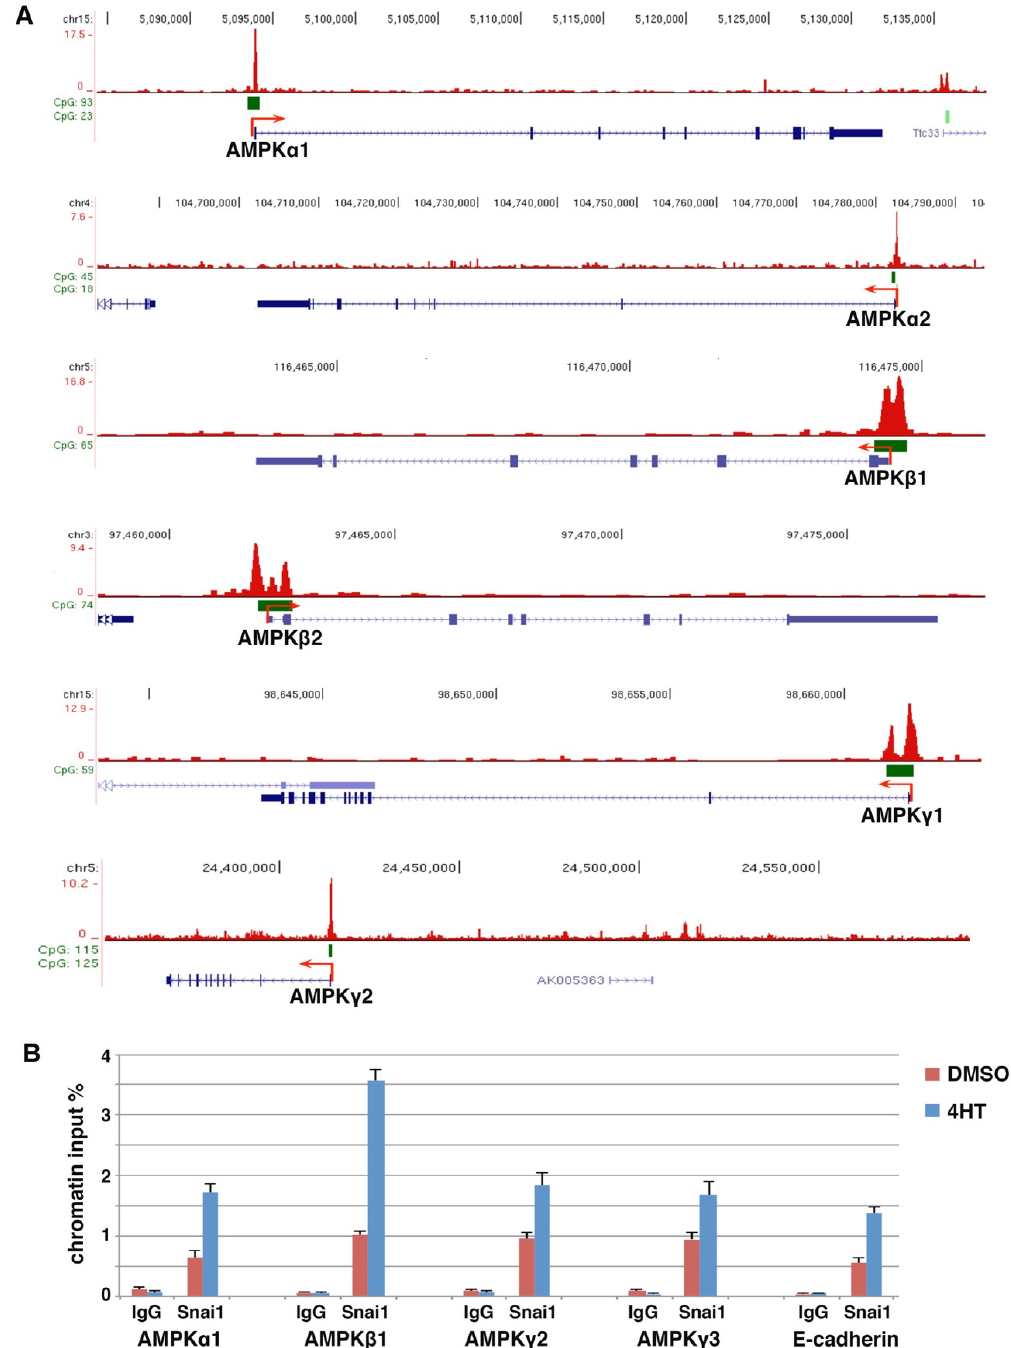
Figure 1. AMPK genes are direct transcriptional targets of Snai1. ( A ) Snai1 genomic binding in mouse MMTV-PyMT mammary carcinoma cells (ChIP-seq dataset GSM1499414) was visualized in the IGV genome browser. Exons (blue bars), CpG islands (green bars), and transcription start sites (red arrows). ( B ) ChIP analysis of Snai1 binding at selected AMPK gene promoters in DCIS-Snai1-ER cells (±4HT for 2 days). E-cadherin served as a positive control.